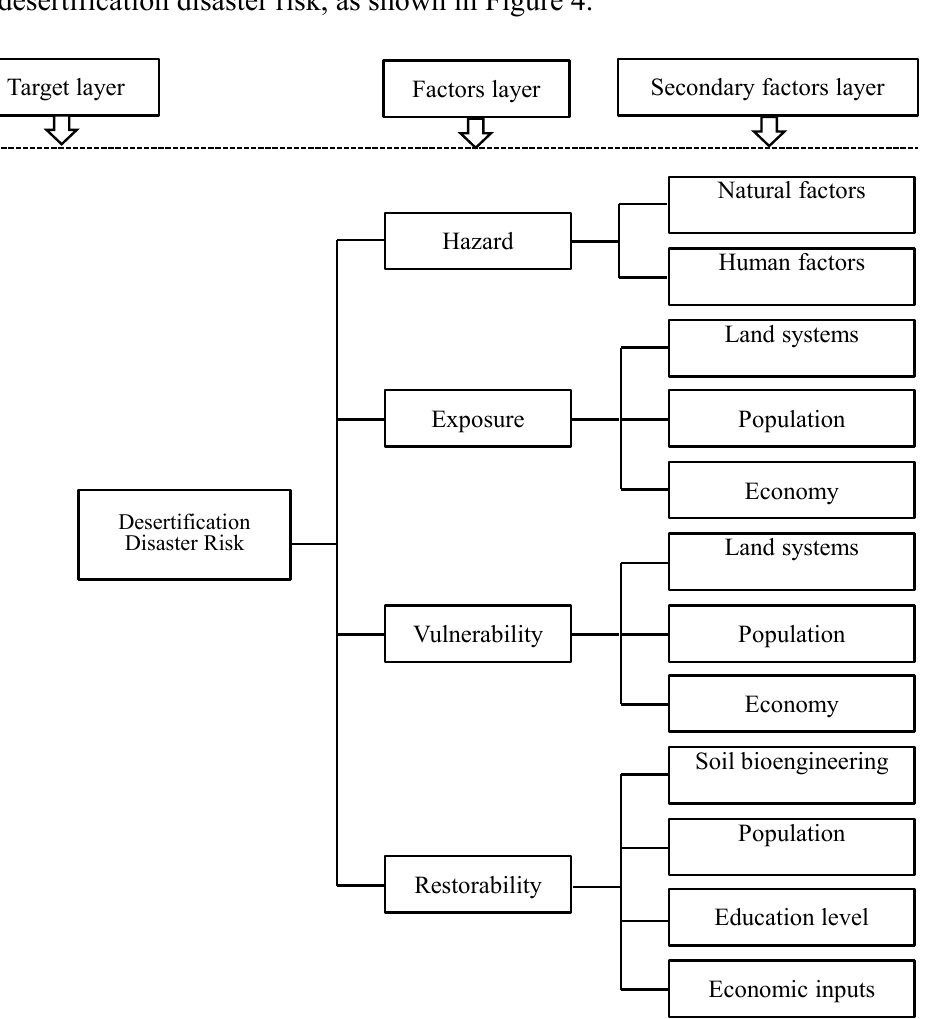
Figure 4. Concept framework of desertification disaster